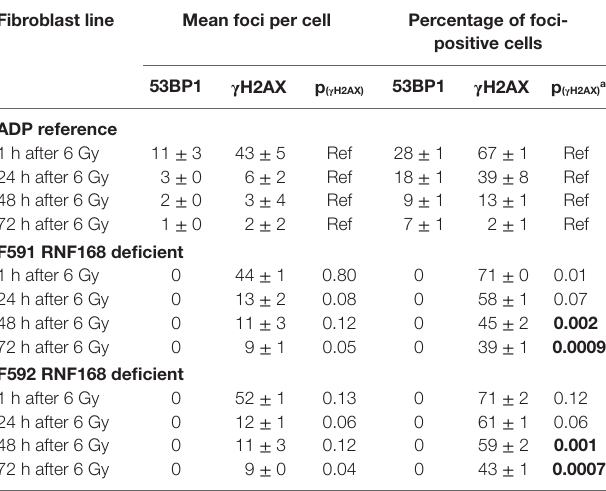
TaBle 1 | Monitoring DNA repair protein foci in fibroblasts with RNF168 deficiency. Fibroblast